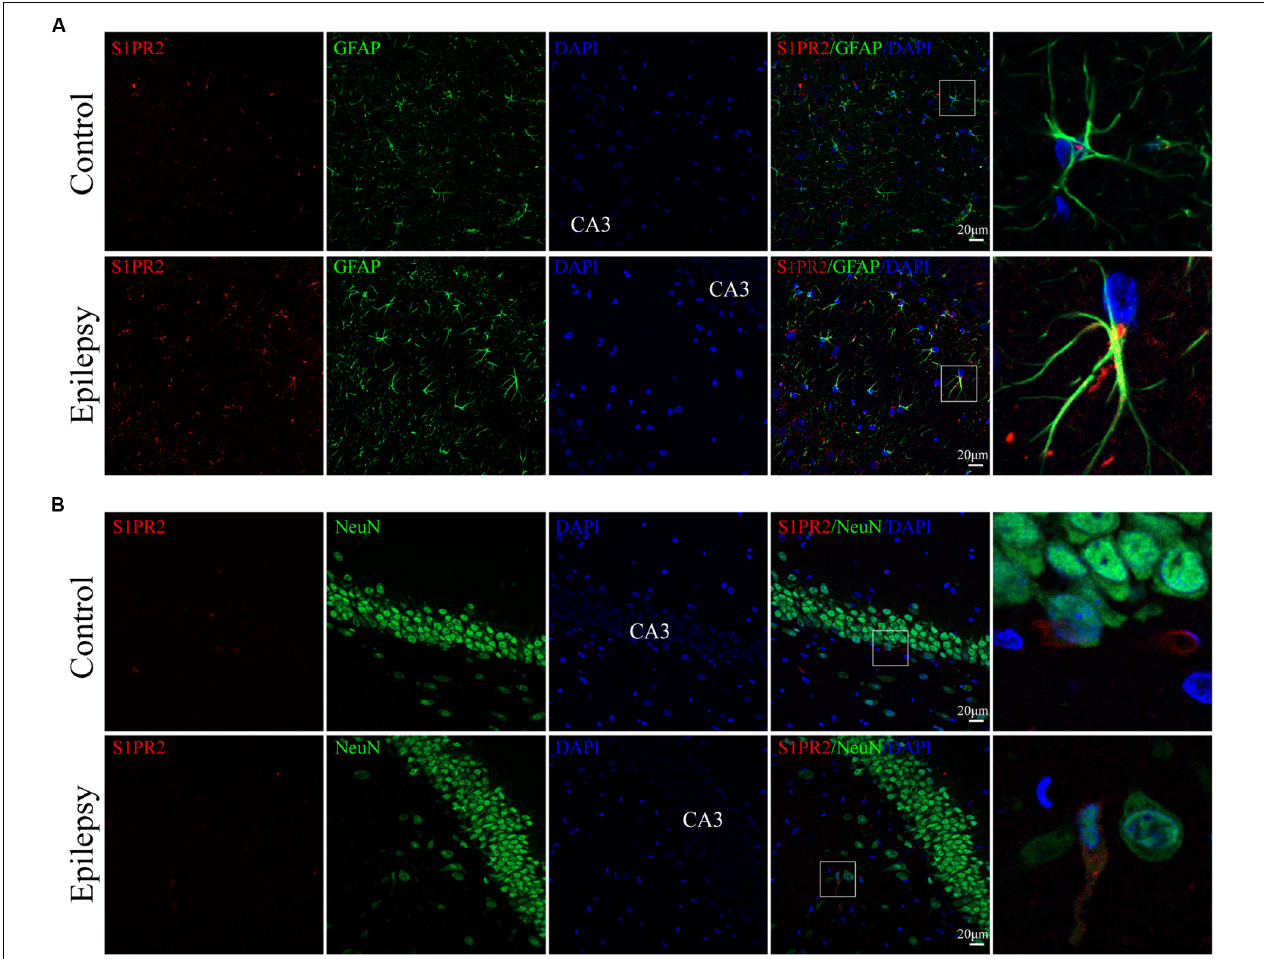
FIGURE 5 | Cellular localization of S1PR2 in hippocampal tissues from epileptic rats. ( A , left) Confocal images showing co-localization of S1PR2 and DAPI in astrocytes. ( A , right) Enlarged view of indicated co-localization between S1PR2 with astrocytes. ( B , left) Confocal images showing co-localization of S1PR2 and DAPI in neurons. ( B , right) Enlarged view of indicated co-localization between S1PR2 with